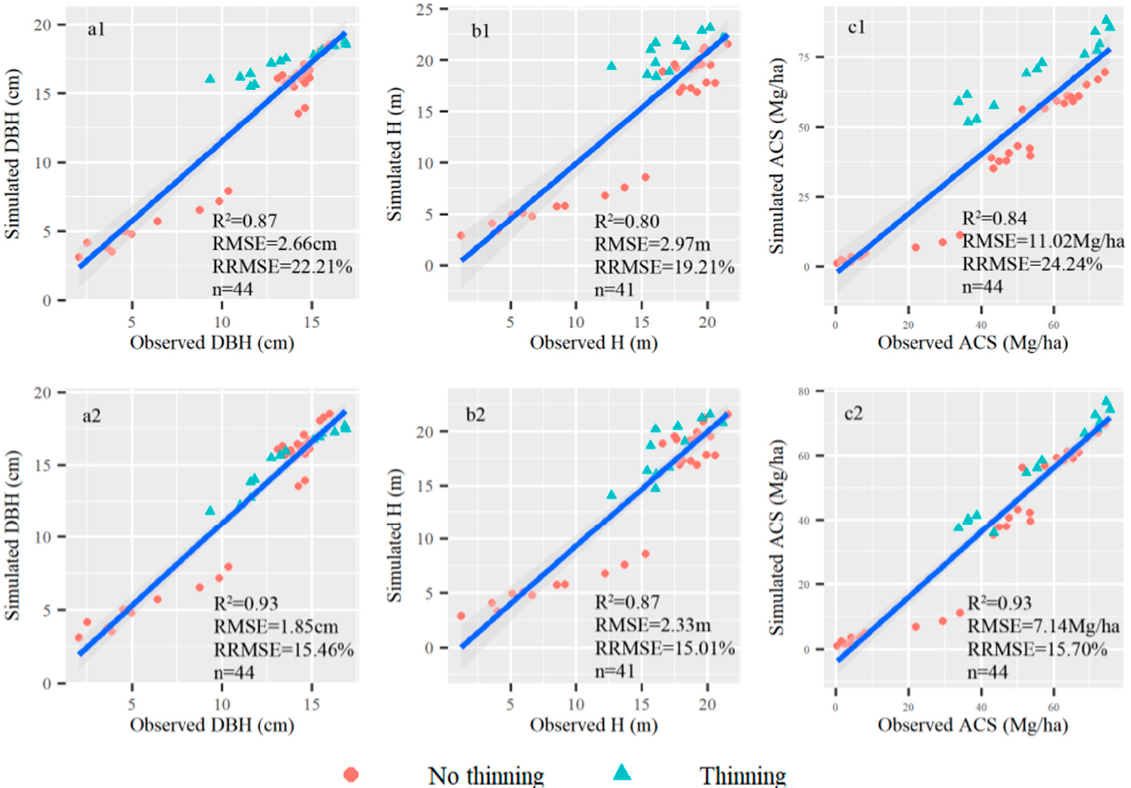
Figure 5. Validation of simulated forest structure at the SP. Plots a1 , b1 , and c1 are simulated diameter at breast height, height, aboveground carbon stock of not considering thinning in the model; a2 , b2 , and c2 are simulated diameter at breast height, height, aboveground carbon stock of considering thinning. No thinning and thinning denote whether the SP thinned or not during the growth.